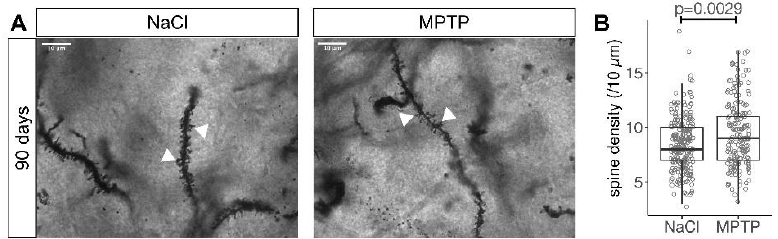
Figure 5. Recovery of spine density 90 days after MPTP. ( A ) Representative images of Golgi stained MSN dendrites (arrowheads) 90 days after the last MPTP injection. Scale bars 10 µ m. ( B ) Number of spines in a 10 µ m stretch of dendrite. Each marker represents one MSN. Numbers of MSN are in Table 1. p value is from Mann–Whitney test.